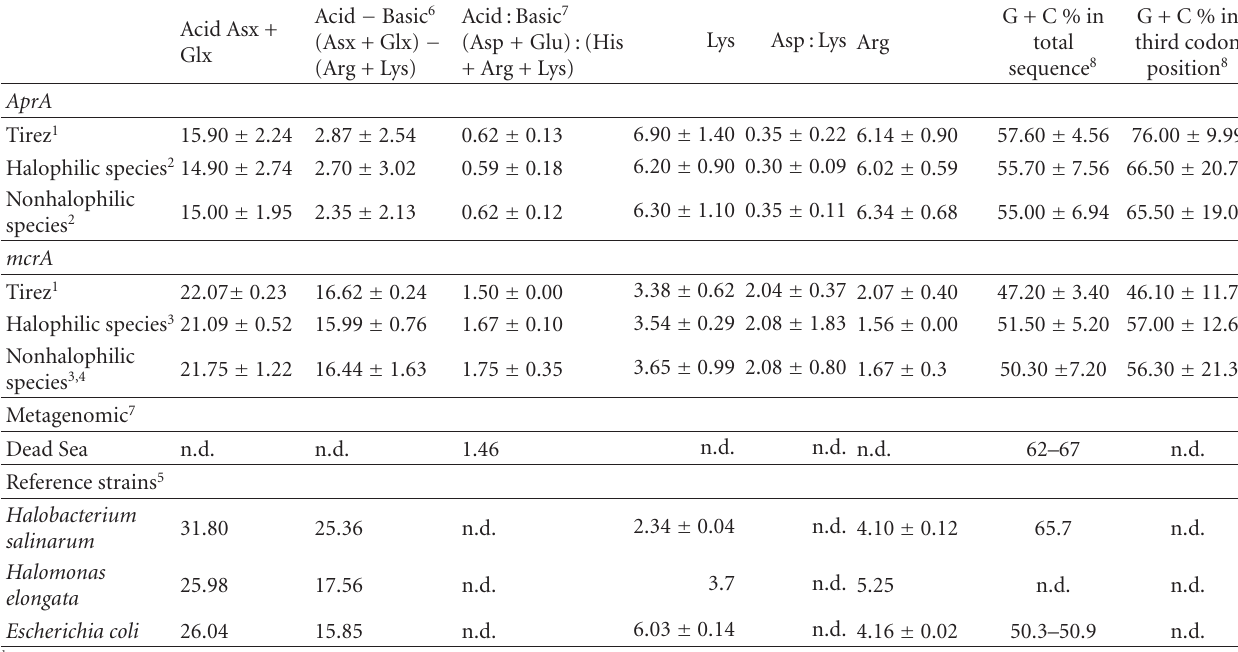
Table 1: The amino acid composition and G + C content of Tirez McrA and AprA sequences, their halophilic and nonhalophilic homologous counterparts, metagenomes, and reference